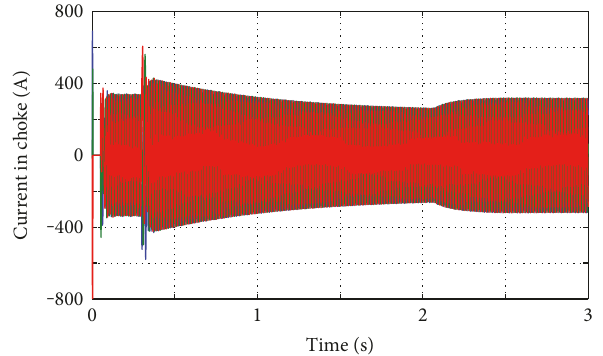
Figure 19: Primary current during LVRT.